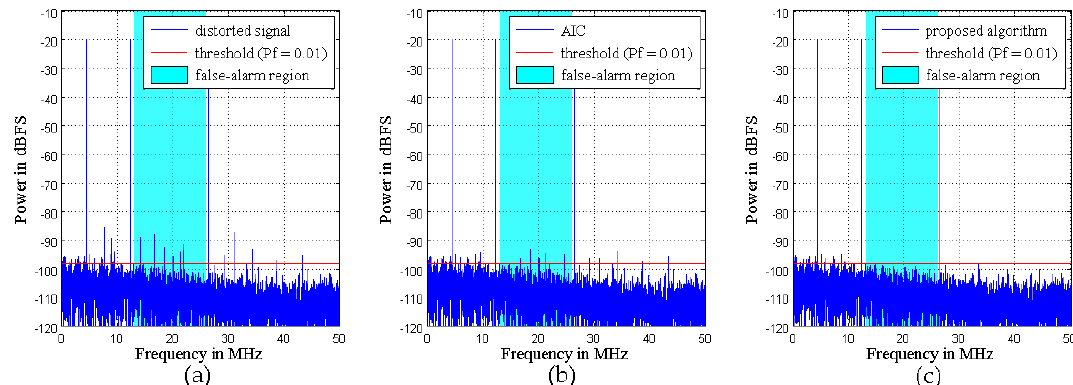
Figure 13. Simulation results with a three-tone interferer signal: ( a ) distorted signal; ( b ) mitigated output of AIC; ( c ) mitigated output of the proposed algorithm.